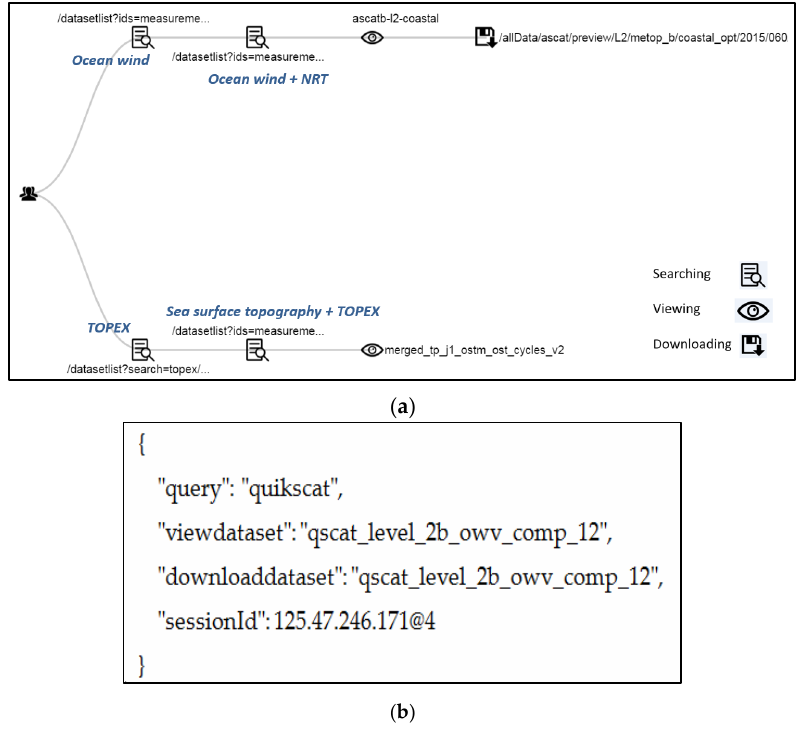
Figure 4. Example session structure results. ( a ) Session structure tree; ( b ) Query set.